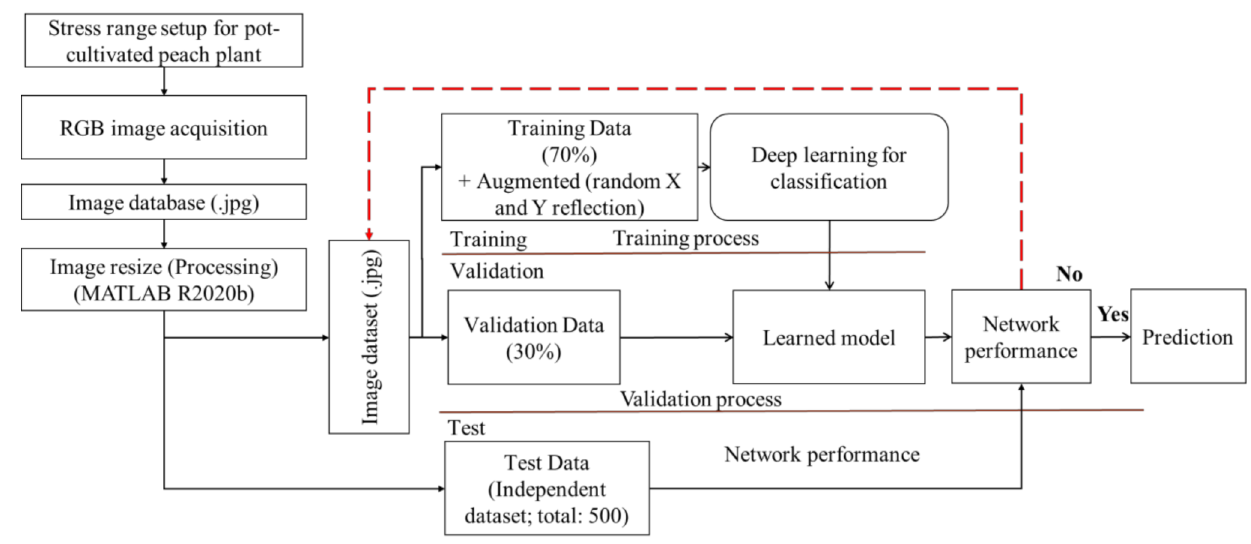
Figure 5. Schematic diagram of the network image dataset preparation and